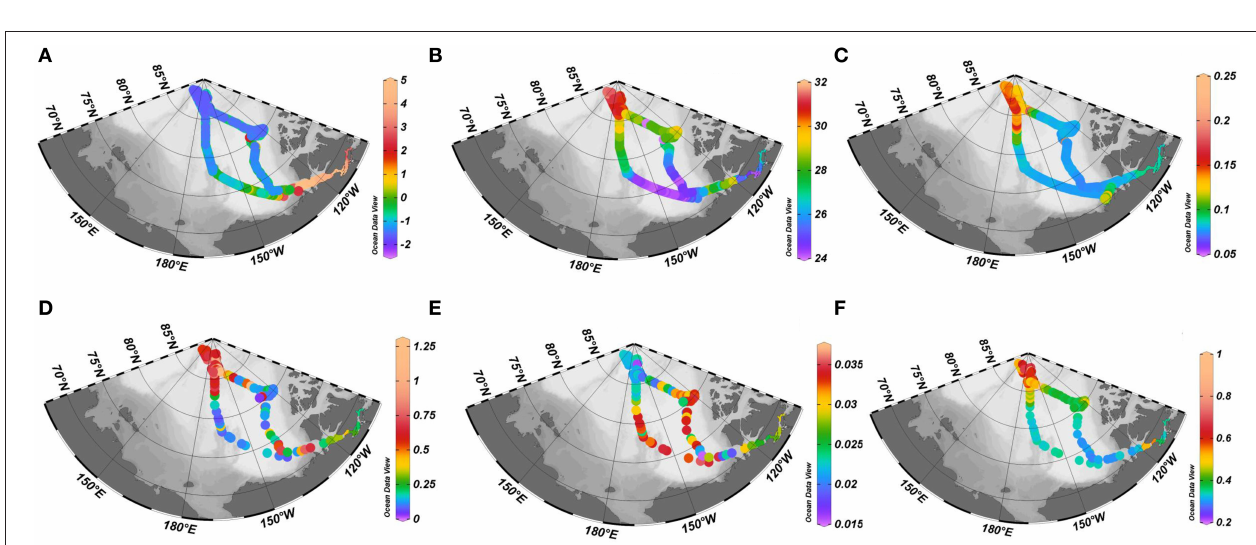
FIGURE 3 | Surface distributions of (A) temperature ( ◦ C), (B) salinity (psu), (C) FDOM WETLabs (in volt), (D) a 370 (m − 1 ) (E) S 275 − 295 (nm − 1 ), and (F) fluorescence Chla (mg/m 3